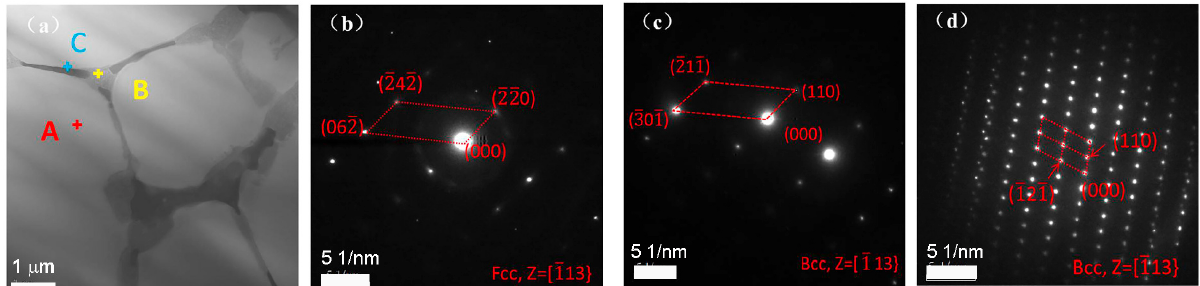
Figure 5. TEM micrographs for the AlCoCrFeNiTi 0.5 coating: ( a ) bright field image of DR and IR phases, ( b ) SADP of bulk area A, ( c ) SADP of GB area B, ( d ) SADP of GB area C. Reprinted with permission from Ref. [62]. Copyright 2021